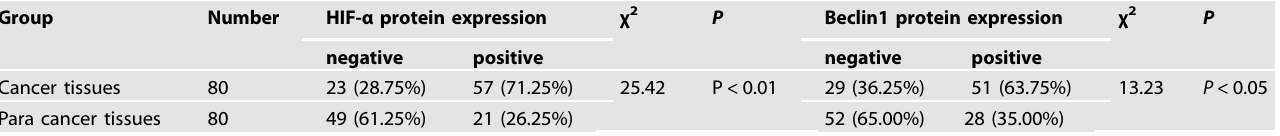
Table 2. Expression difference of HIF-1 α and Beclin1 in OSCC tissues and para cancer tissues ( n ,